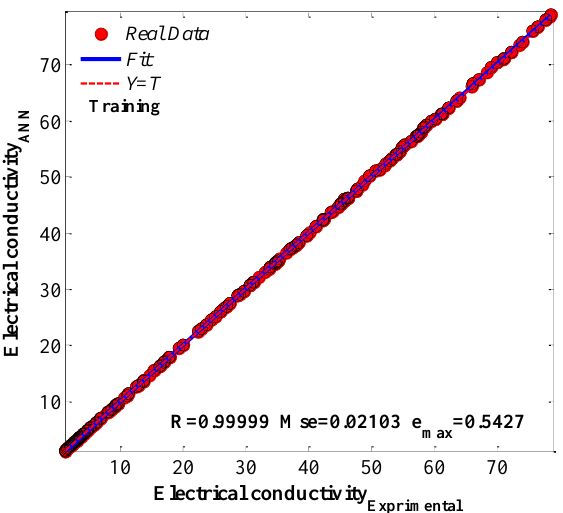
Figure 6. Comparison of predicted values of electrical conductivity of nanofluids by neural networks and experimental results for training data.